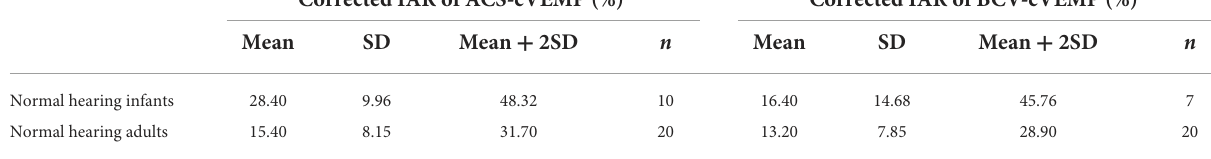
TABLE 7 The Corrected IAR of ACS-cVEMP and BCV-cVEMP in group I and group III. Corrected IAR of ACS-cVEMP